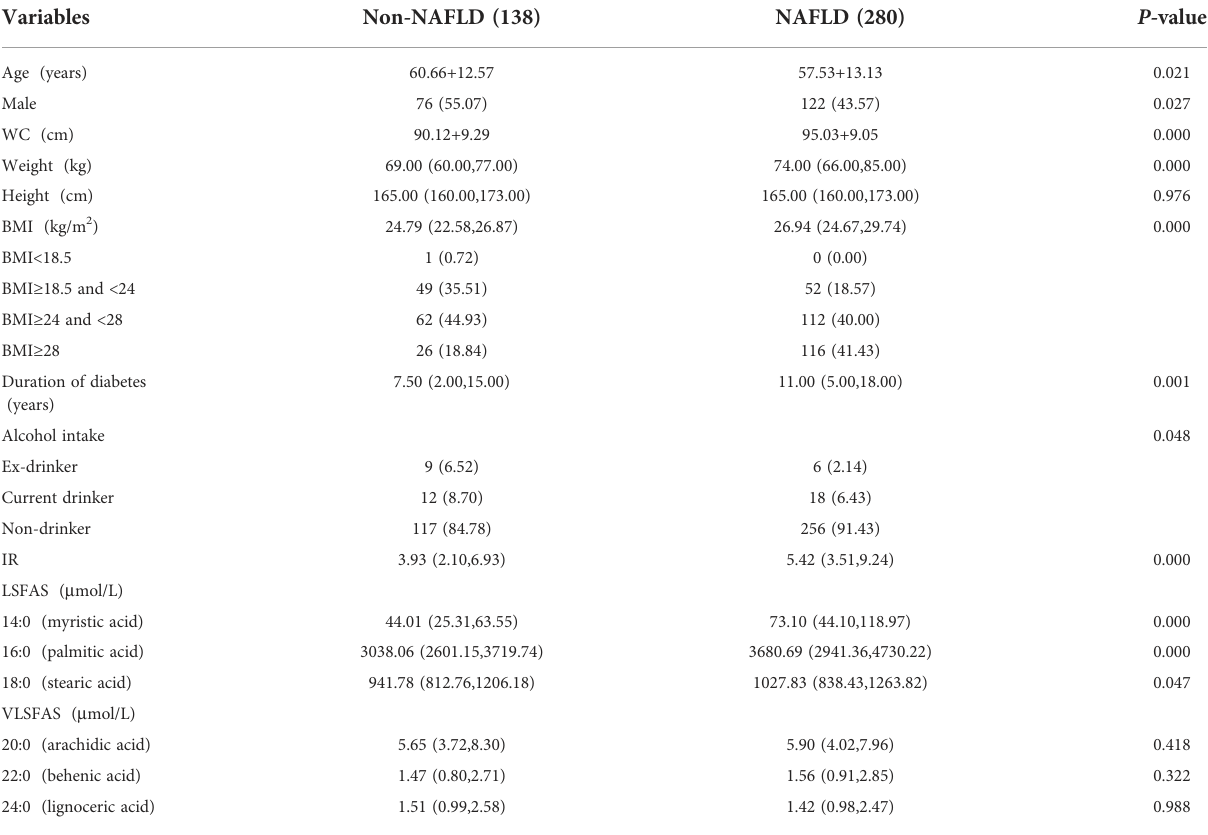
TABLE 1 Baseline characteristics of participants with or without nonalcoholic fatty liver